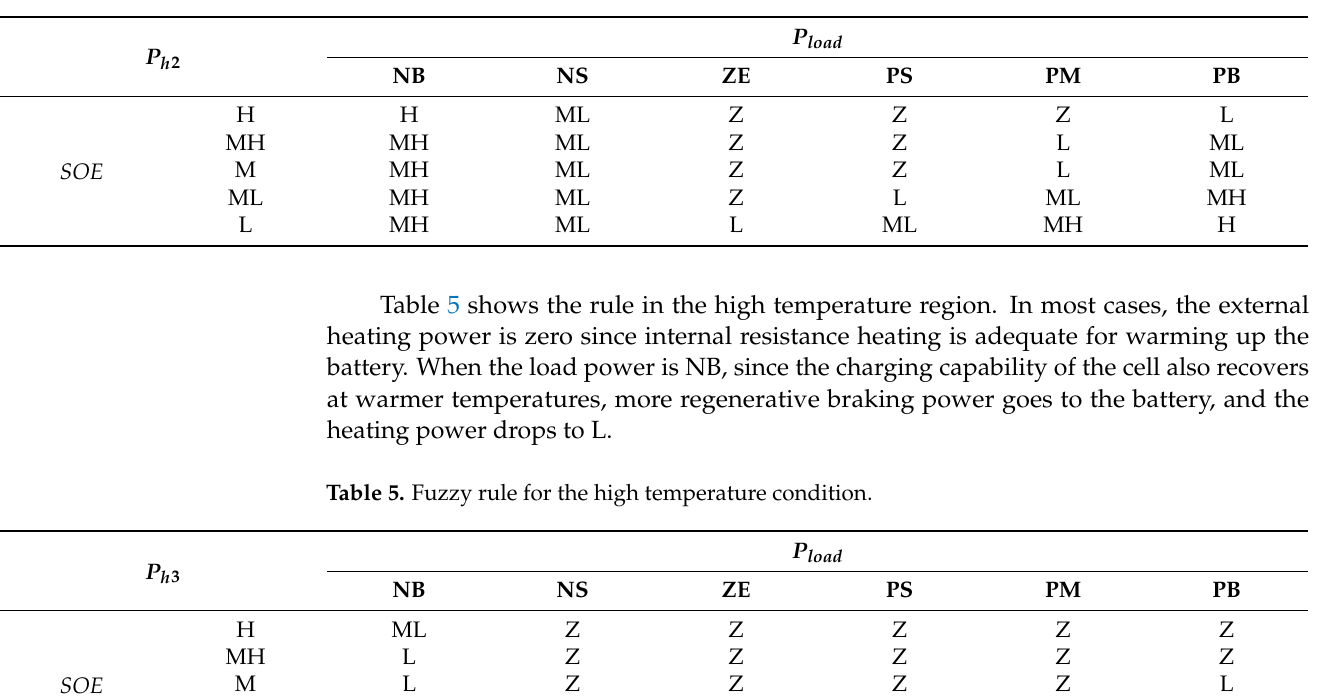
Table 4. Fuzzy rule for the medium temperature condition.